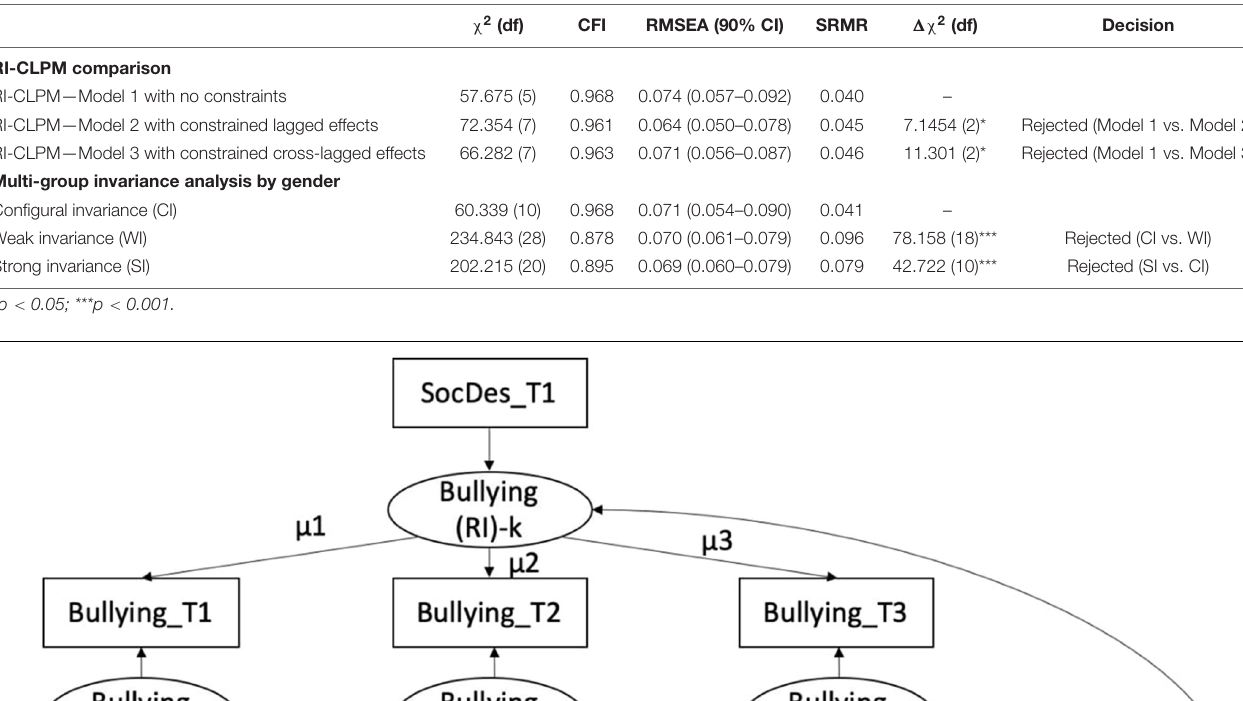
TABLE 4 | Summary of the fit indices for RI-CLPM comparisons and for multi-group invariance analysis by gender.